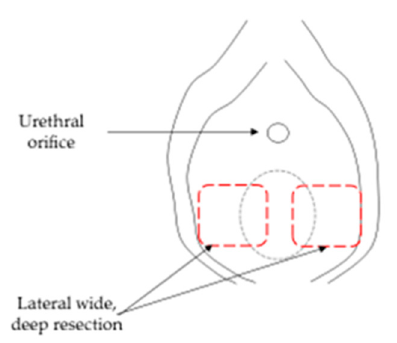
Figure 3. Lateral wide, deep resection for operating vaginal agenesis.